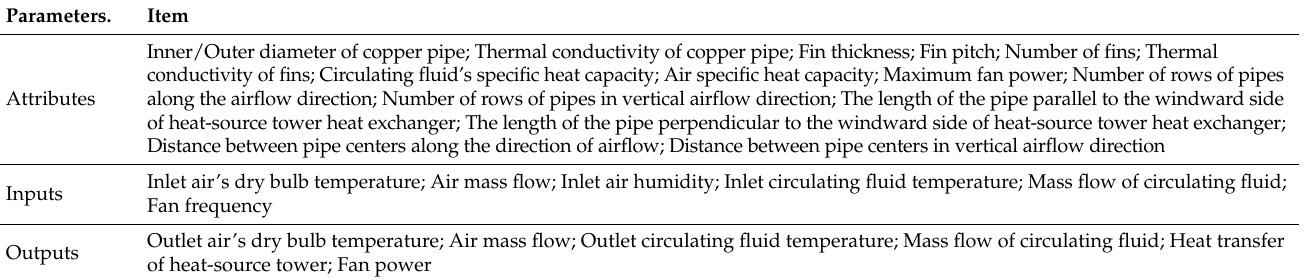
Table 1. The parameters, inputs and outputs of TRNSYS calculation